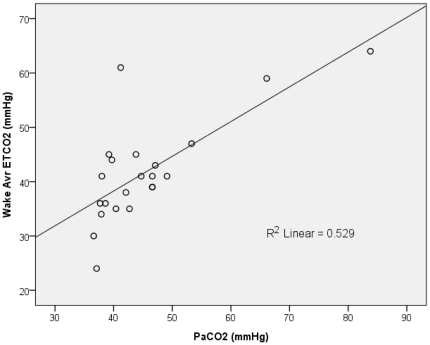
The average level of end-tidal carbon dioxide (ETCO2) measured by waking supine capnography correlated significantly with arterial partial pressure of carbon dioxide (PaCO2) level, as measured by arterial blood gas analysis (p<0.001).